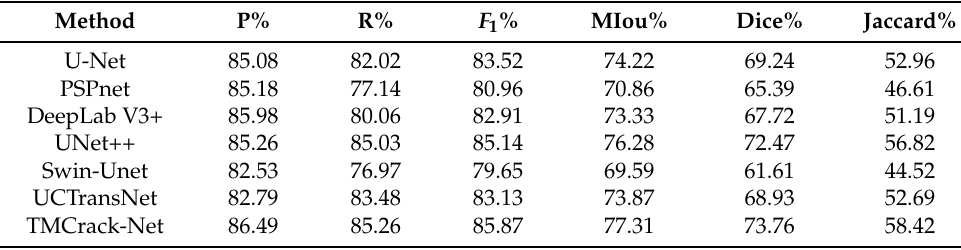
Table 5. Performances of different methods on